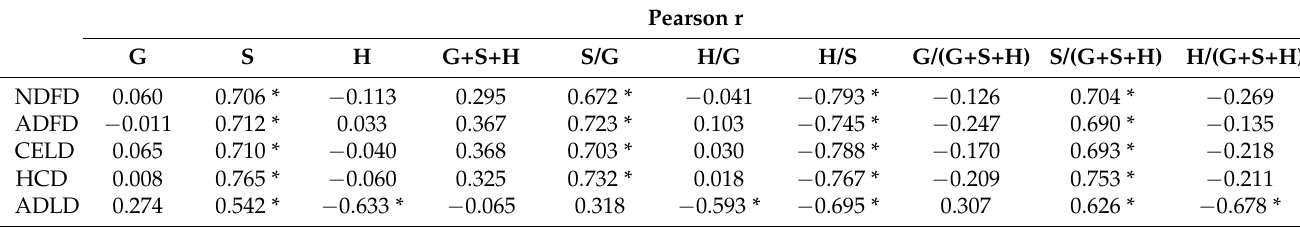
Table 6. Correlation between lignin composition and fiber fractions degradation